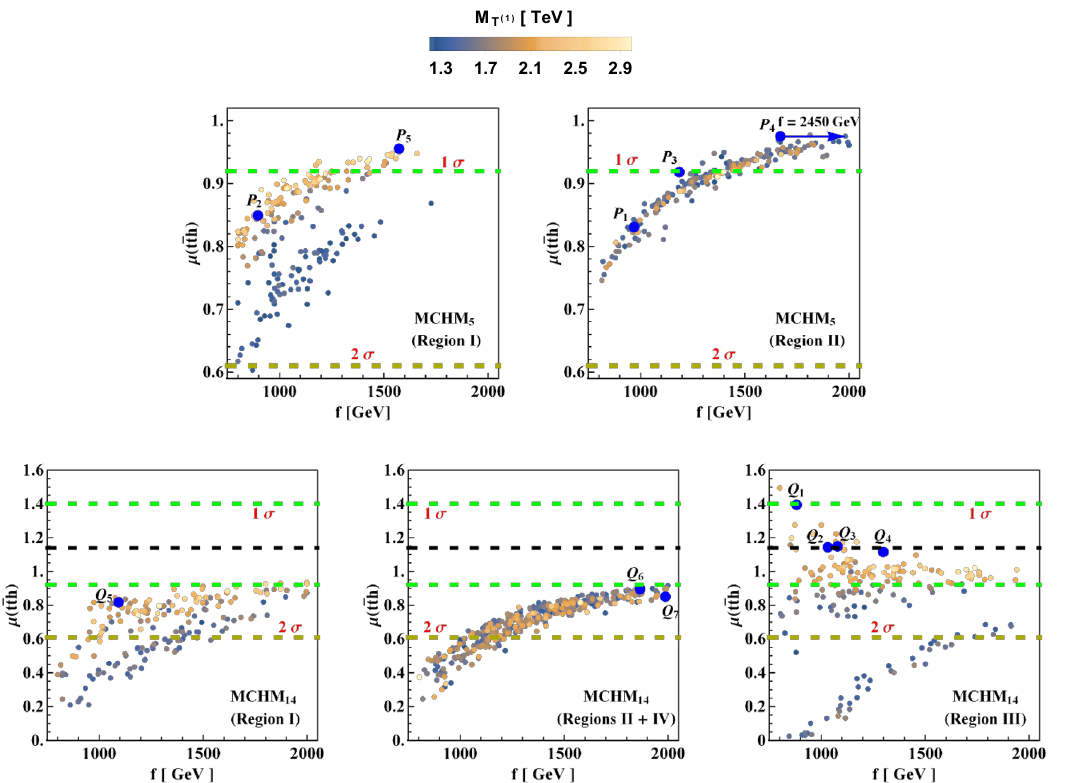
Figure 7 . Normalized tth cross section as a function of f for 14 TeV CM energies. We also color code the lightest vector-like mass. The upper left (right) plot corresponds to the Region I (II) of the MCHM 5 . The lower left, central and right plots correspond to the Regions I, II + IV and III of the MCHM 14 , respectively. The blue arrow in the upper right plot indicates that the example point P 4 is outside the horizontal range of the plot with f = 2450 GeV. The green (brown) dashed line shows the 1 σ ( 2 σ ) limits given by the CMS µ ( tth ) measurements while the black dashed line represents the central value